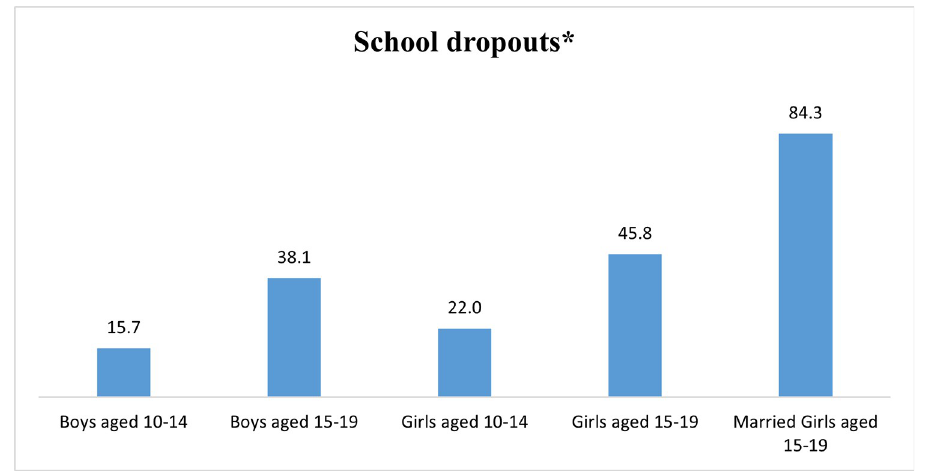
Fig 1. School dropout among adolescent boys and girls, and married girls, 2018–19. � overall dropouts: those who were in schooling/correspondence at wave 1 and discontinued at wave